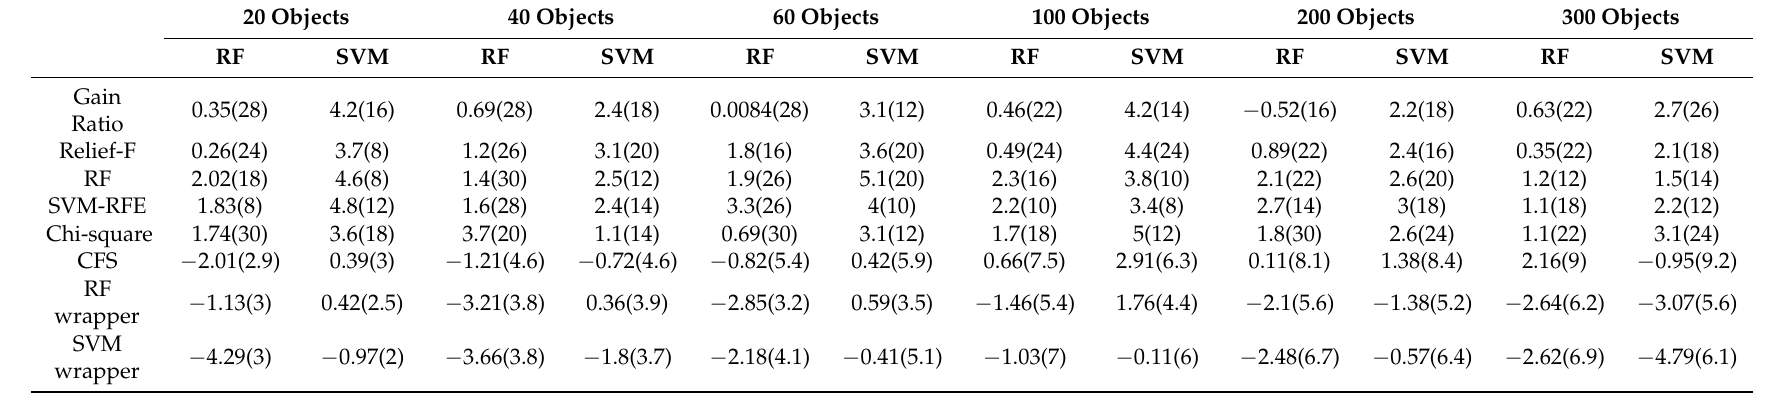
Table 3. Summary of the differences between the best accuracy for the selected feature subsets and that derived using all features. The statistical value was derived from a two-tailed t -test, and the difference is significant at the 0.05 significance level if the absolute value of the test statistic is greater than 1.96. The positive number indicates that the best mean accuracy for the feature subsets was better than that derived using all features, otherwise the latter was better than the former. The values in brackets are the number of features used for the best classification